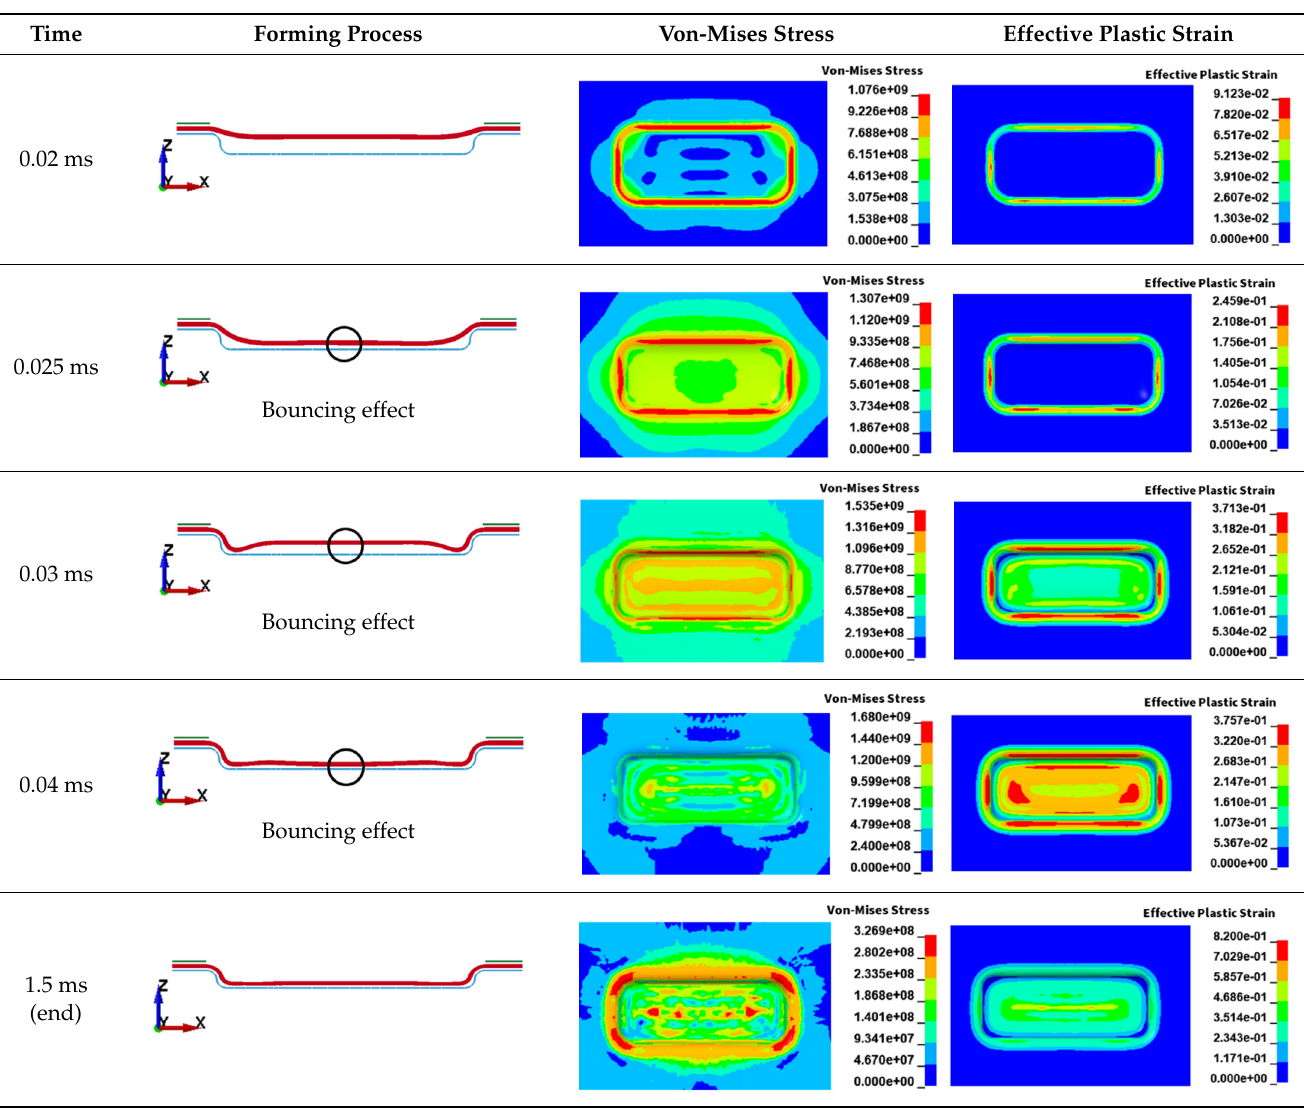
Table 7. Von Mises stress and effective plastic strain distribution diagram corresponding to EMF (CASE 2, depth 4 mm).